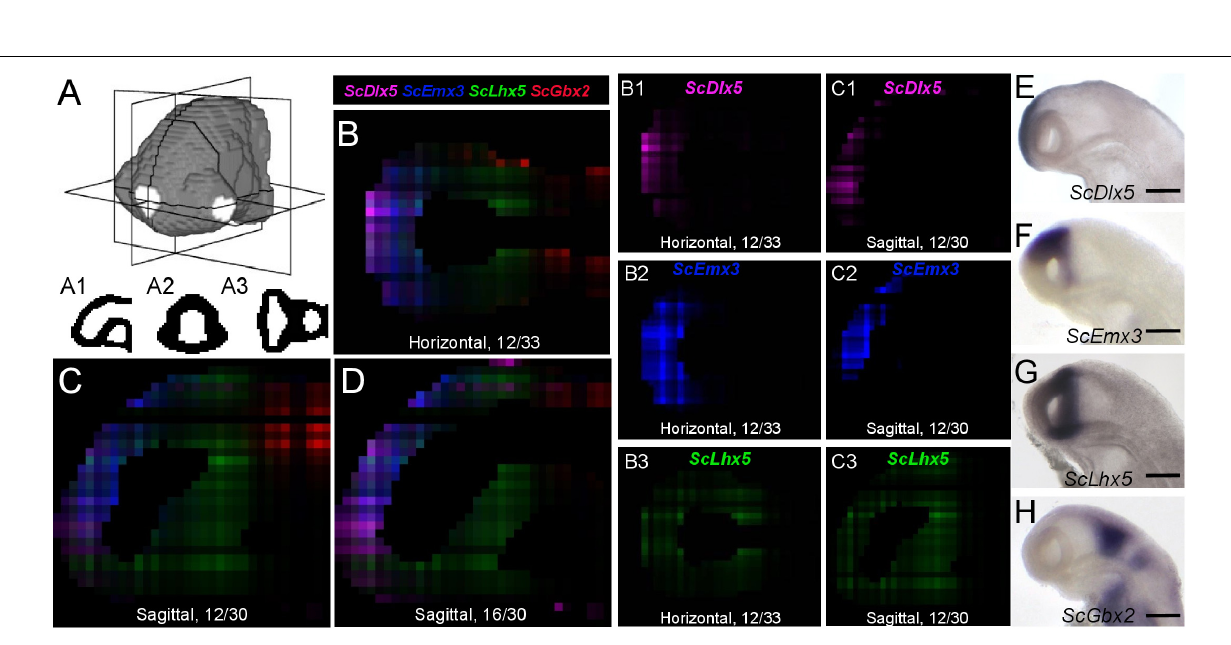
Frontiers in Cell and Developmental Biology |